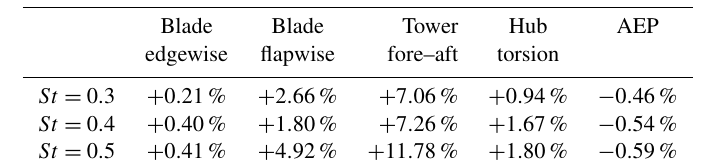
Table 3. Percentage increases in the Weibull-weighted DELs and AEP (from 3 to 25ms − 1 ) of the excited turbine compared to the baseline